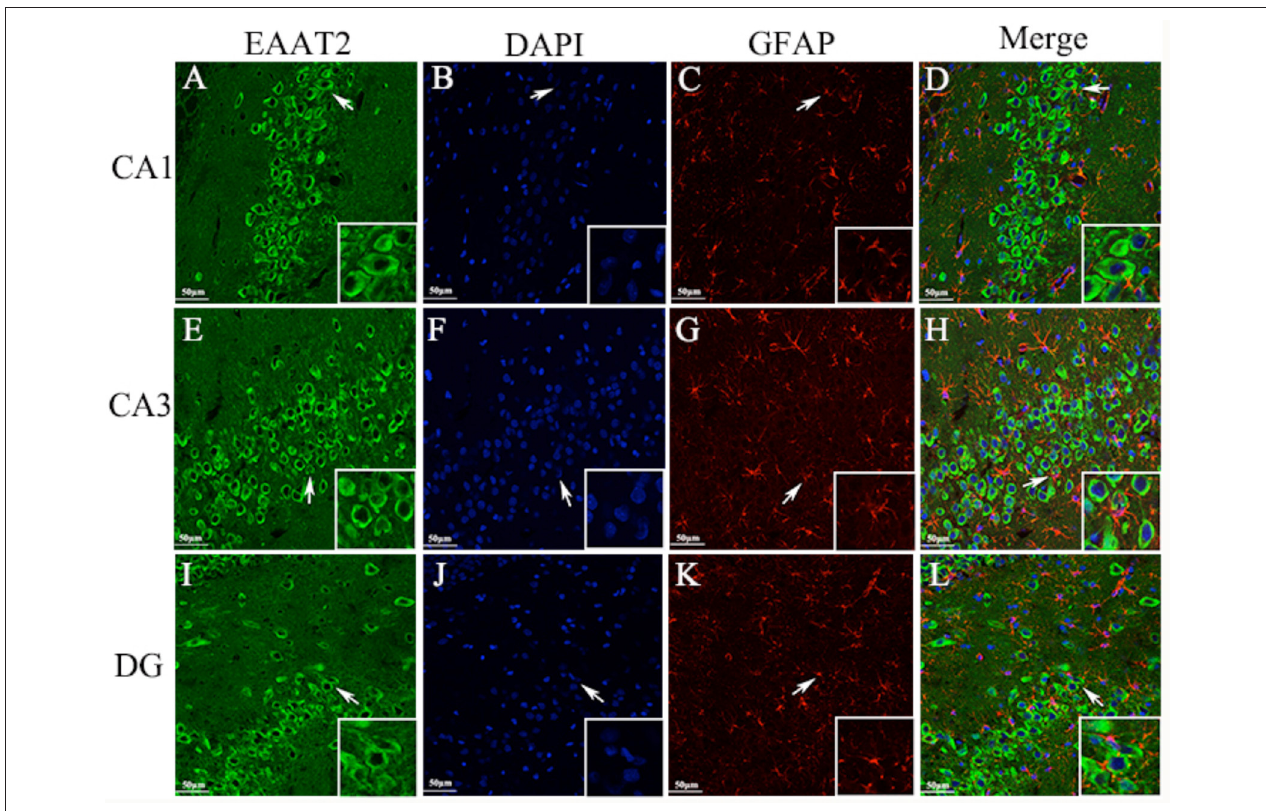
FIGURE 8 | Astroglia (A–L) . Same as Figure 7